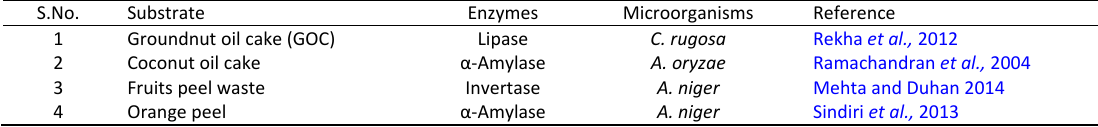
Table 6: Bio enzymes from different fruit wastes